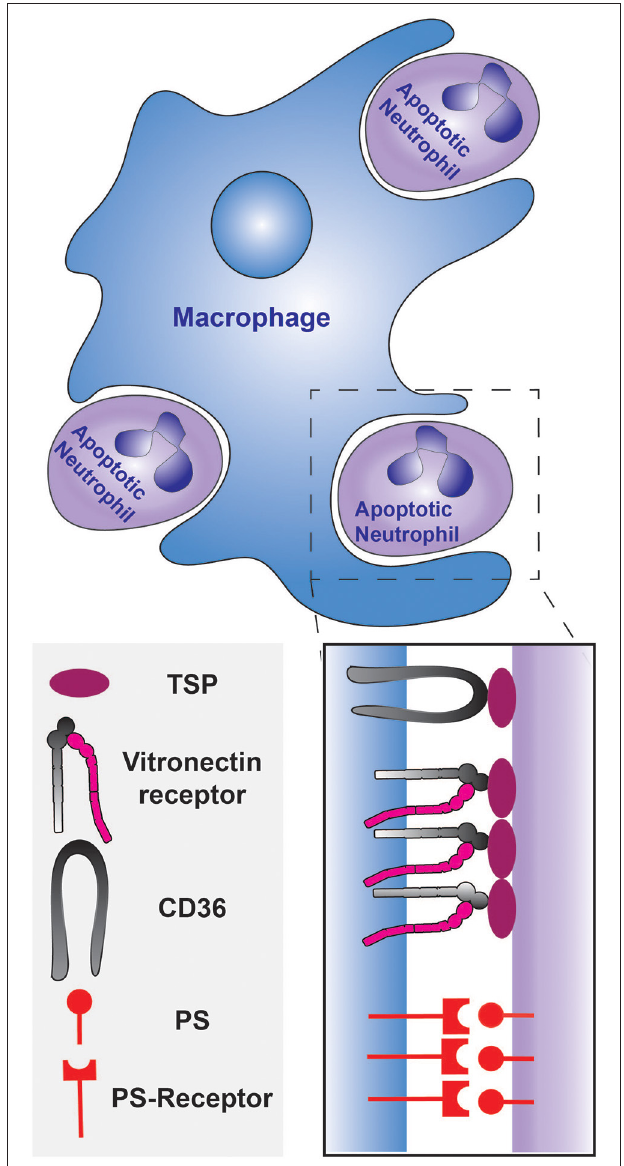
FIGURE 1 | Phagocytosis of apoptotic neutrophils by a macrophage during the resolution of inflammation. The engulfment can be mediated by PS and/or the opsonization of the apoptotic neutrophils by thrombospondin. The thrombospondin-coated apoptotic cells are tethered to the macrophage by CD36, and the vitronectin receptor signals the initiation of phagocytosis. PS is recognized by the PS-receptor on the macrophage.